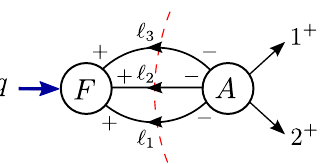
(1 + ; 2 + ; q ). This cut is O S ; O C